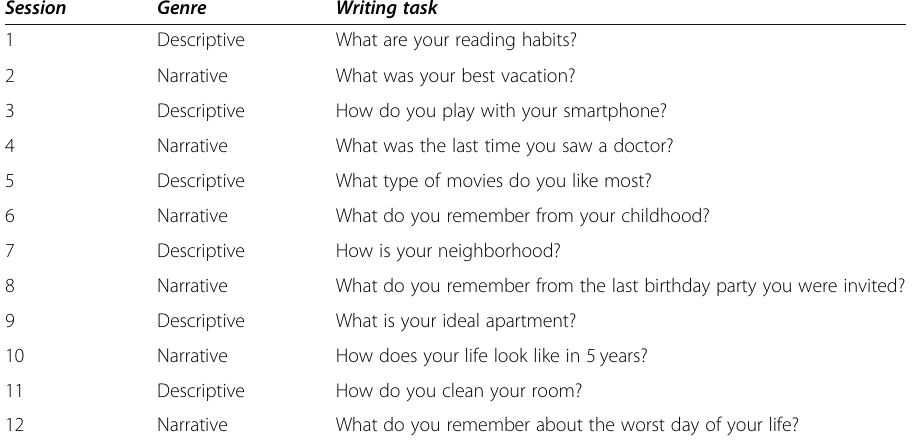
Table 2 Topics and arrangement of the descriptive and narrative writing elicitation